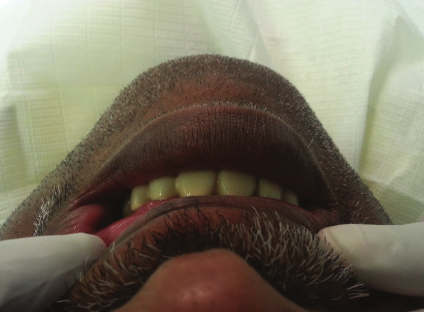
Figure 7: Establishment of proper lip position over the maxillary